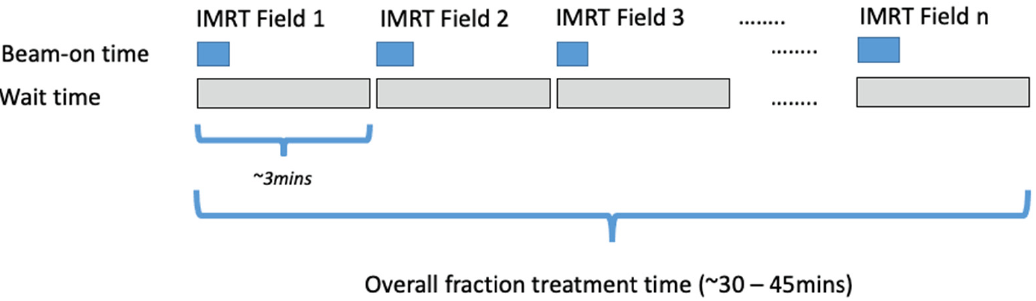
Figure 2. Schematic diagram illustrating the delivery of a PRDR treatment fraction using fixed-field IMRT technique. The diagram depicts the temporal sequence of individual field delivery during the treatment fraction.